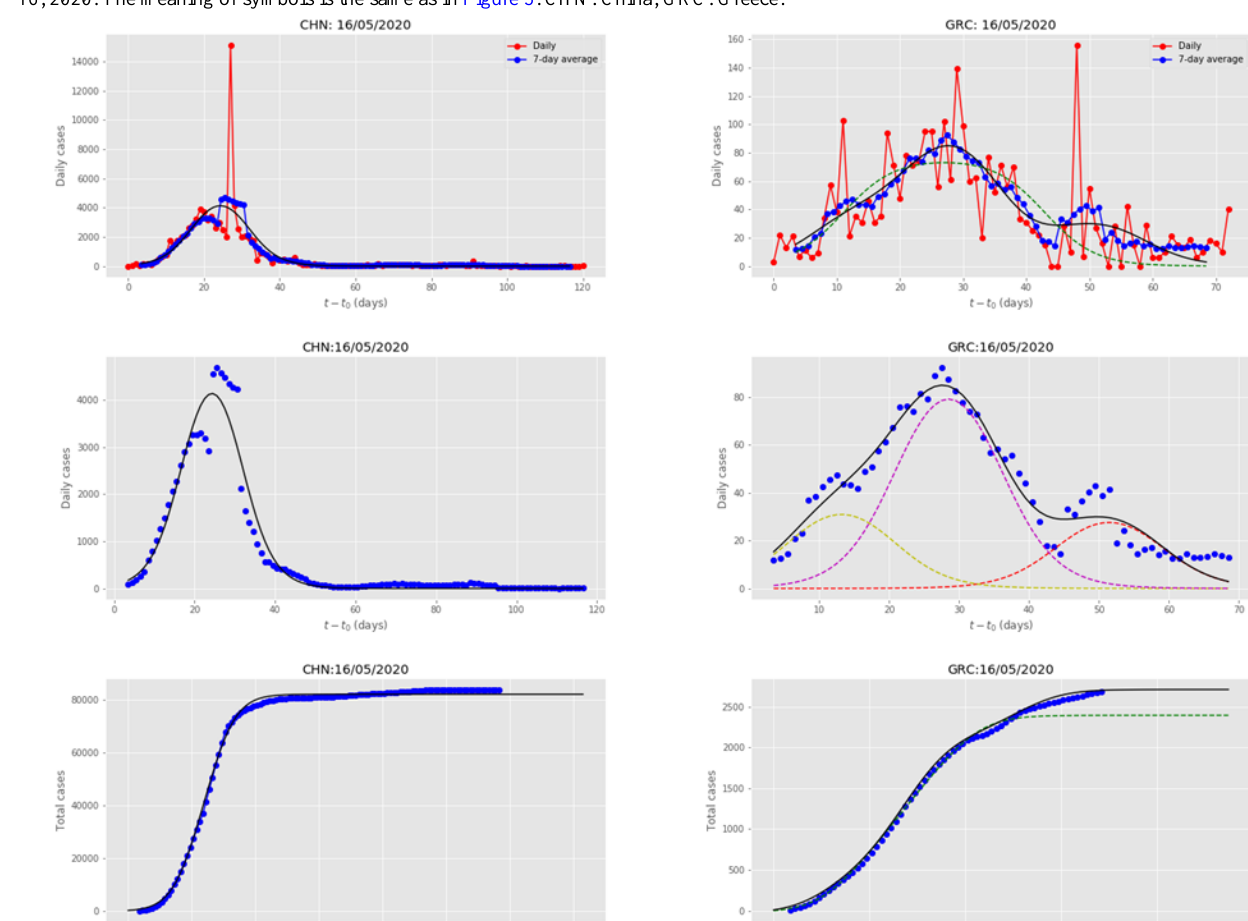
Figure 7. Results for CHN and GRC, obtained by fitting the multiple-wave forced-susceptible-infectious-removed (FSIR) model with data up to May 16, 2020. The meaning of symbols is the same as in Figure 5. CHN: China; GRC: